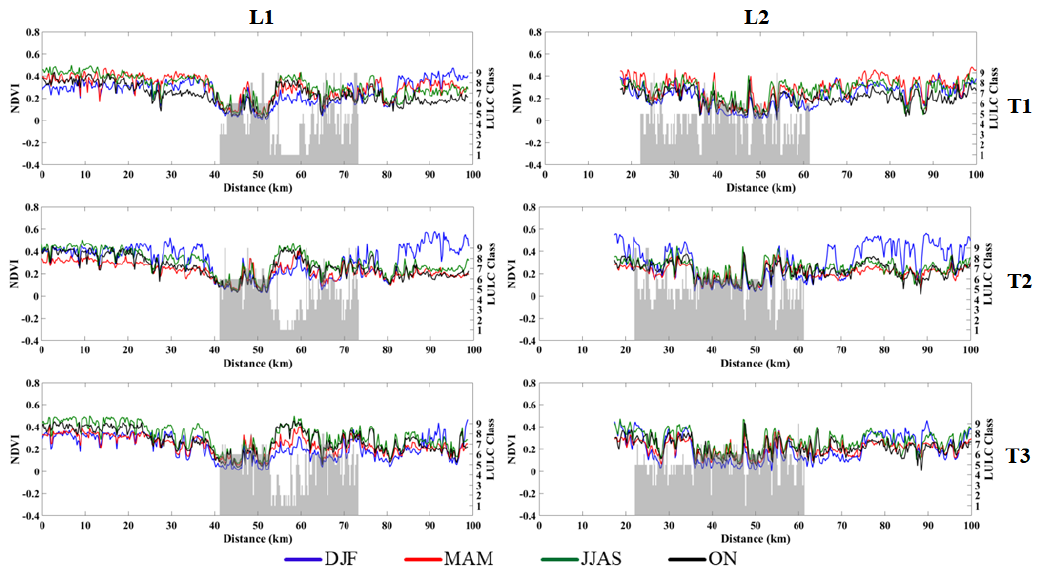
Figure 4. Same as Figure 3, but for NDVI.